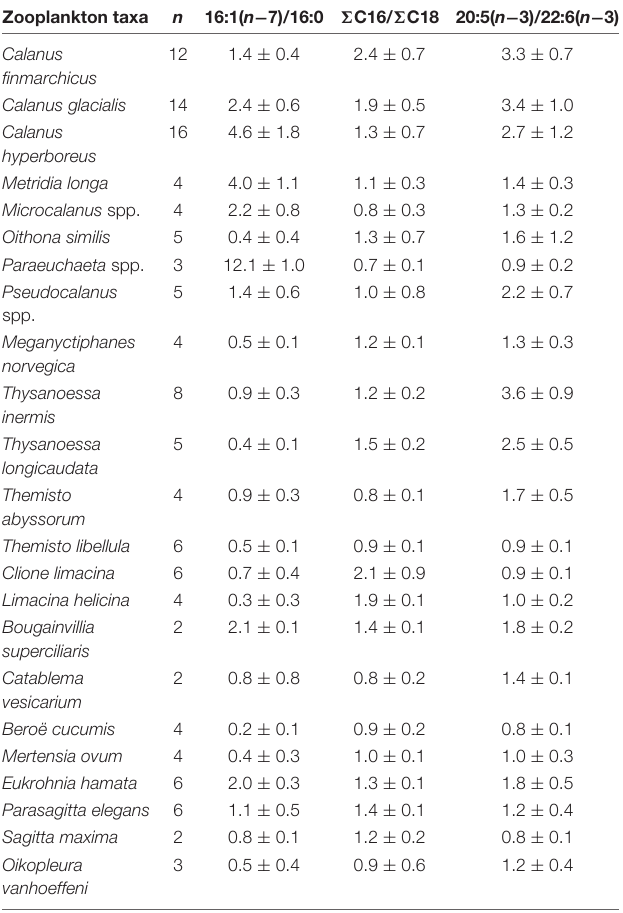
TABLE 3 | Ratios of fatty acids (FAs; mean ± SD) in zooplankton collected during Nansen Legacy cruise Q3 in August 2019 in the Barents Sea. Zooplankton taxa n 16:1( n − 7)/16:0 (cid:54) C16/ (cid:54) C18 20:5( n − 3)/22:6( n − 3)